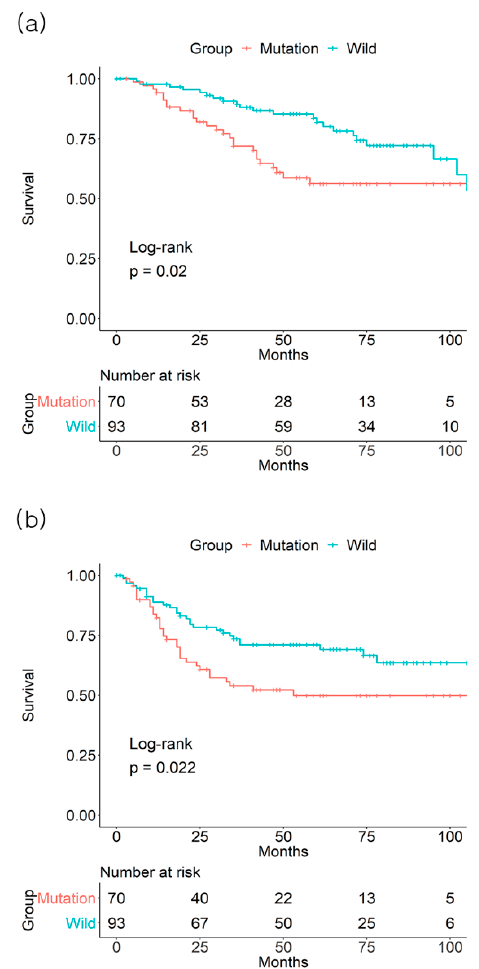
Figure 5. Effect of KRAS mutation on ( a ) 3-year overall survival and ( b ) 3-year disease-free survival from the GSE39582 database of colorectal cancer stage III patients.